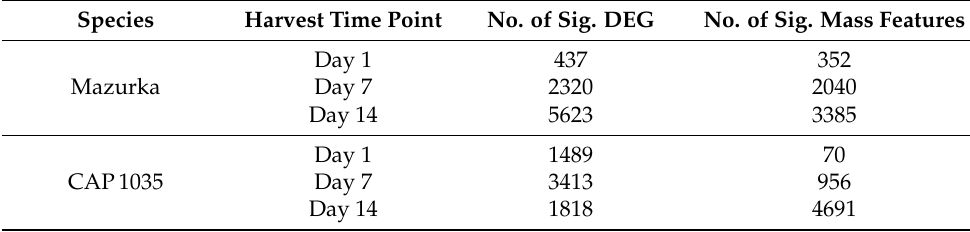
Table 1. Final group details for each DIABLO analysis. Transcriptome and metabolome data were analyzed to define highly correlated genes (differentially enriched genes, DEG) and mass features for each species at each single harvest time point performing first a WGCNA followed by an ANOVA. Species Harvest Time Point No. of Sig. DEG No. of Sig. Mass Features Day 1 437 352 Mazurka Day 7 2320 2040 Day 14 5623 3385 Day 1 CAP1035